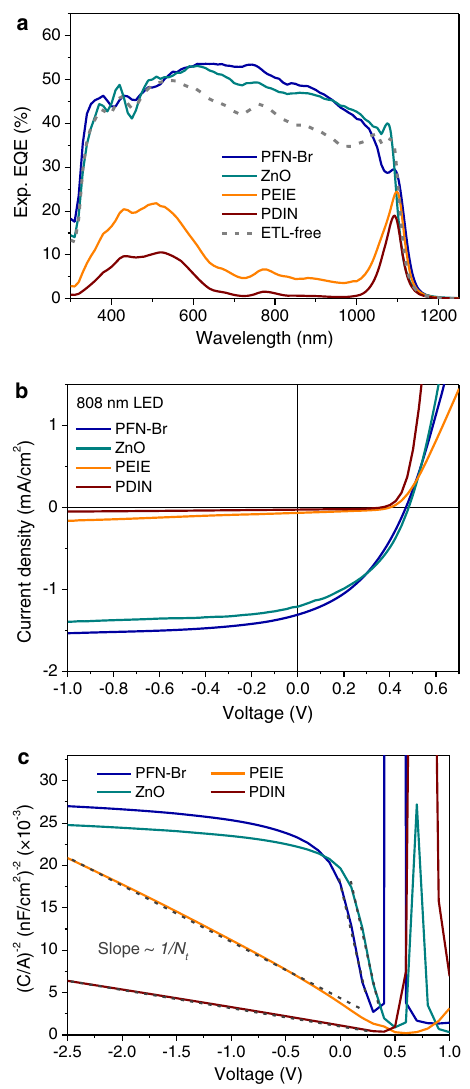
Fig. 2 | The role of electron-transporting layers (ETL) in manipulating EQE shapes.a ETLdependentEQEspectrainaninverted500nmthickPCE10:COTIC-4F photodiode.FortheETL-free(graydashline)inverteddevice,theITOsubstratewas not treated by UV Ozone since it would increase the energy barrier for electron extraction. b Corresponding J – V characteristics measured under a 808nm LED source at ~6 mw/cm 2 . c Mott – Schottky plots of ETL dependent PCE10:COTIC-4F devices, measured at 1kHz in the